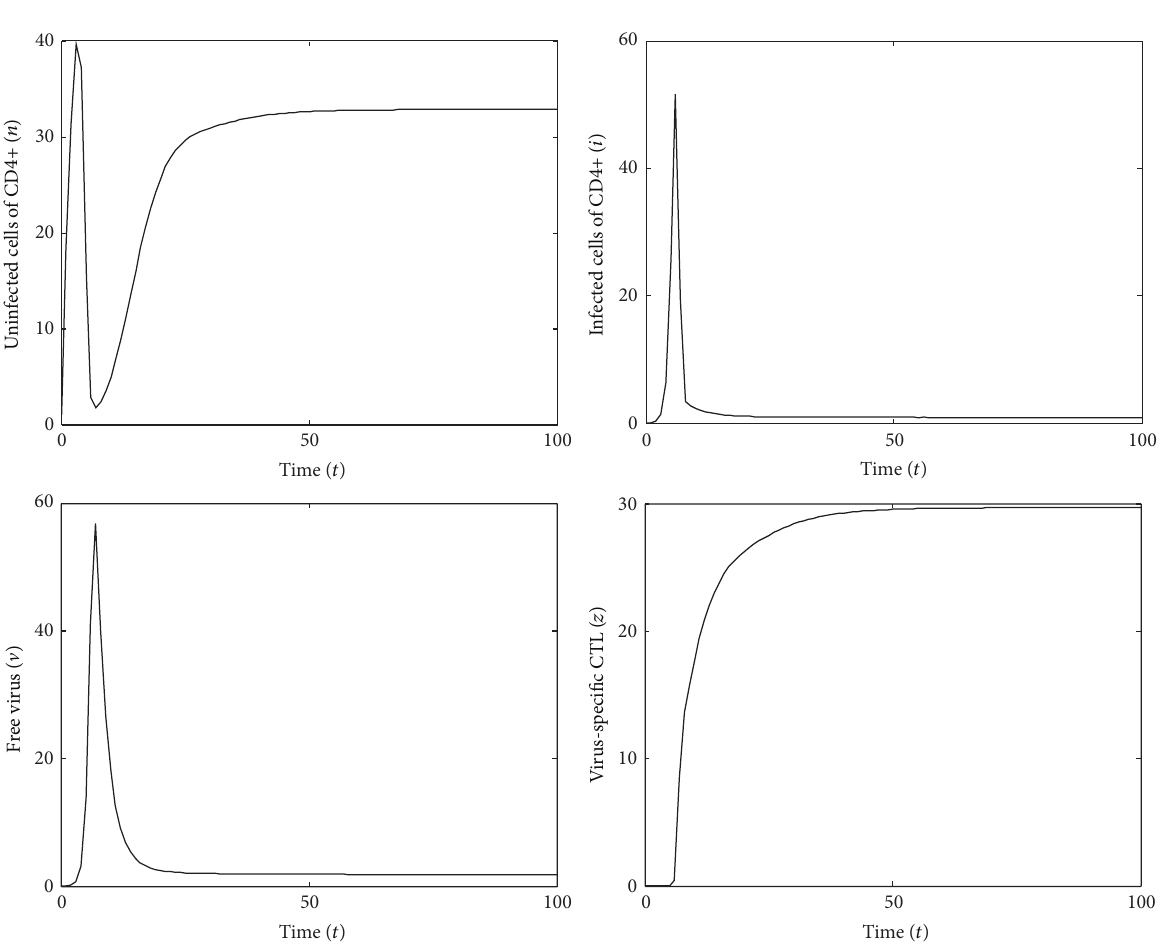
Figure 5: Nonlinear numeric solution of system (3) with